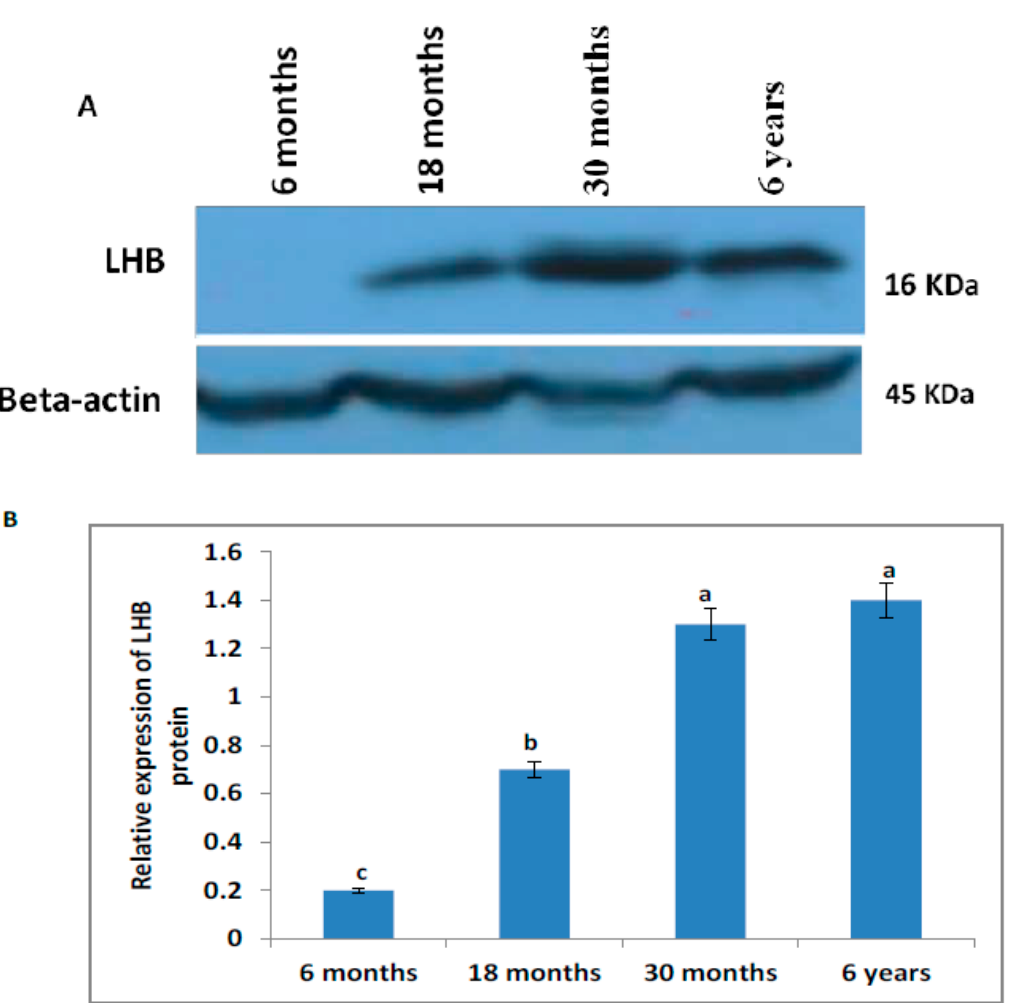
Figure 6. Detection of the expression pattern of LHB protein in Datong yak testis using Western blotting: ( A ) Western blot of LHB protein and ( B ) relative LHB protein expression levels were quantified by densitometric analysis. Protein levels were quantified by densitometric analysis. Different letters indicate significant difference ( p < 0.05).